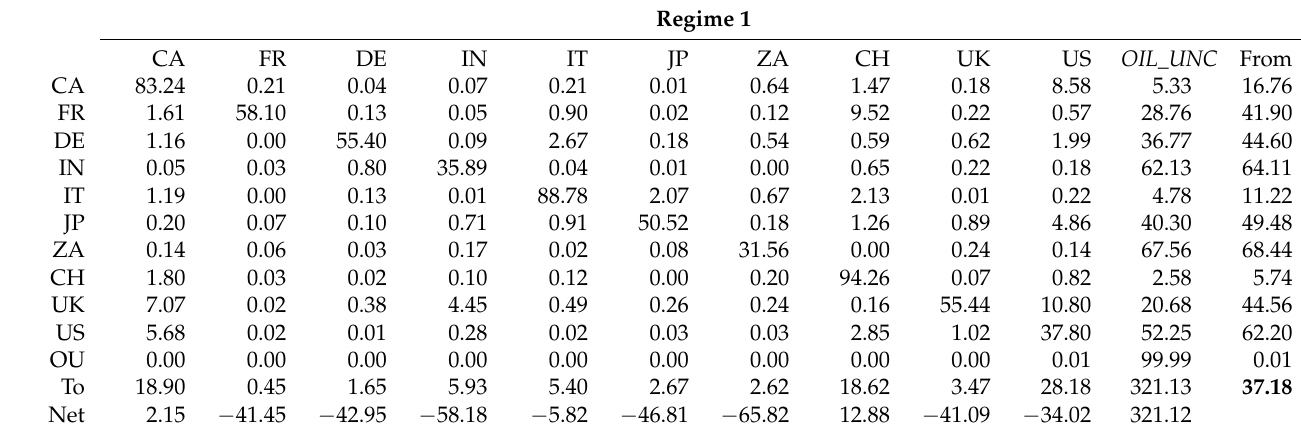
Table A6. Regime-dependent connectedness based on the MSVAR